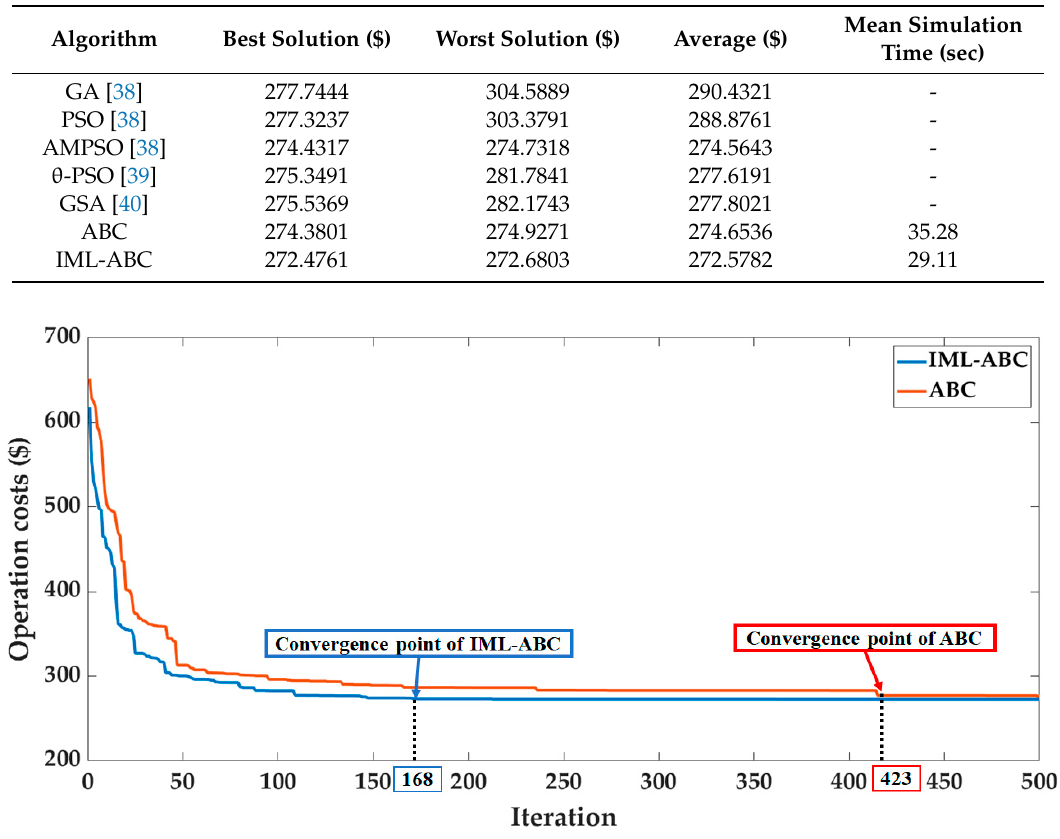
Figure 12. Convergence diagram using both artificial bee colony (ABC) and improved multi-layer (IML)-ABC algorithms.